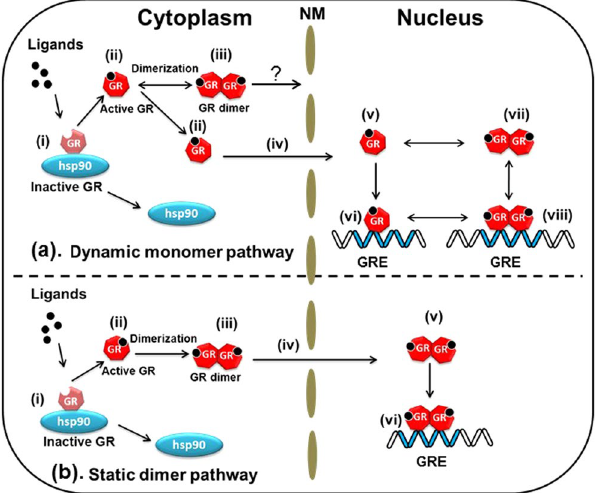
Figure 8. The proposed model for the pathways of glucocorticoid receptors. ( a ) The dynamic monomer pathway: (i) hGR α is localized to the cytoplasm as a complex or in free form in the uninduced state. (ii) hGR α is activated after ligand binding. Activated hGR α in the cytoplasm is in equilibrium between a monomer and dimer (iii) but transport of dimeric hGR α is unclear. (iv) Activated monomer hGR α relocates into the nucleus and is in both the free state (v) and monomer form, which can bind to a GRE as an unstable complex (vi). (vii) hGR α further dimerizes in the nucleus. (viii) The preformed dimer of hGR α associates with the GRE and other transcription factors. The dimer and monomer are not only distributed in the cytoplasm but also in the nucleus even after ligand binding; however, transport of hGR α is carried out in the monomeric form of hGR α . The concentration of hGR α in the nucleus can be controlled by changing the K d of hGR α and GRE in the nucleus. ( b ) The static dimer pathway: (i) hGR α is localized to the cytoplasm as a complex or in free form in the uninduced state. (ii) hGR α is activated after ligand binding. Activated hGR α exists in the cytoplasm as a dimer (iii). (iv) In the dimer form, hGR α is translocated. The preformed dimer (v) of hGR α associates with a GRE and transcription factors (vi). The dimer of hGR α is distributed in both the cytoplasm and nucleus, but the monomer is found only in the cytoplasm. hGR α is transported in the dimer form. The concentration of hGR α in the nucleus can be controlled by the activity and functions of the NPC. hGR α : human glucocorticoid receptor α , hsp90: heat shock protein 90, GREs: glucocorticoid response elements, NM: nuclear membrane, NPC: nuclear pore